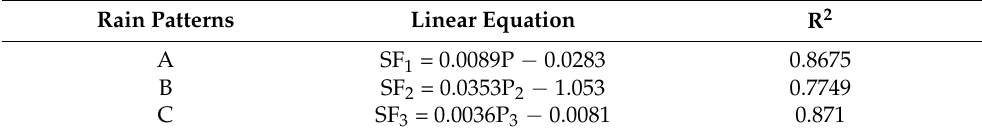
Table 4. Estimation for each rainfall pattern for SF and